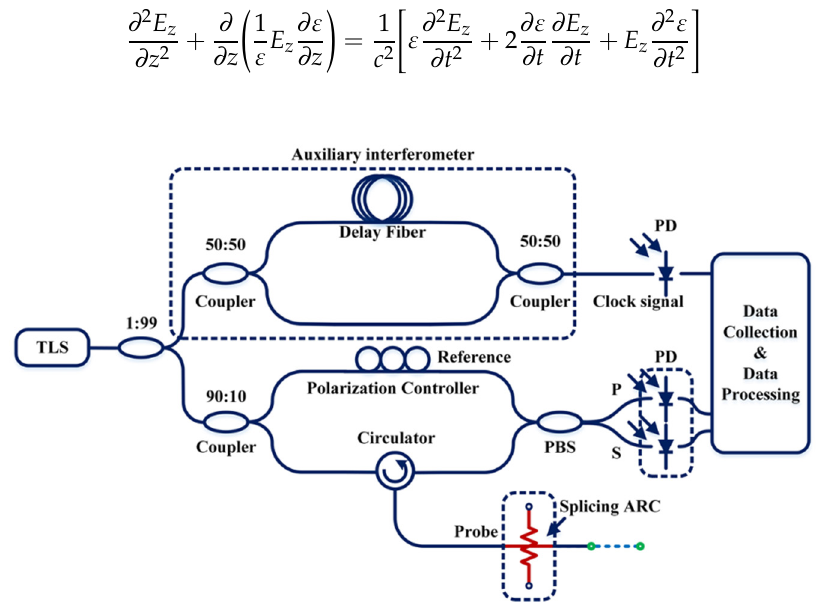
Figure 1. Schematic of the optical frequency-domain reflectometry (OFDR) system for electrical arc discharge measurement applied with different currents.